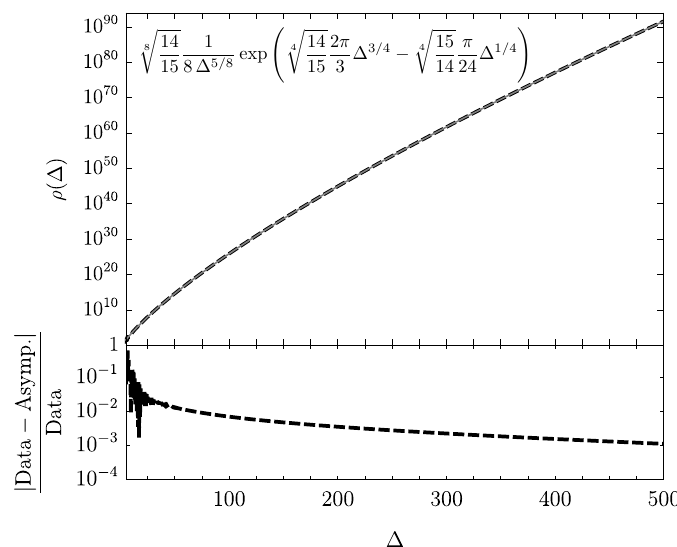
Figure 2: The growth of operators for a fermion in d = 4. Upper panel: The thick dashed line corresponds to exact data, obtained by a direct expansion of the PE. The thin grey curve that is indistinguishable from the data in the upper panel is the asymptotic result. Lower panel: Relative error between data and the asymptotic